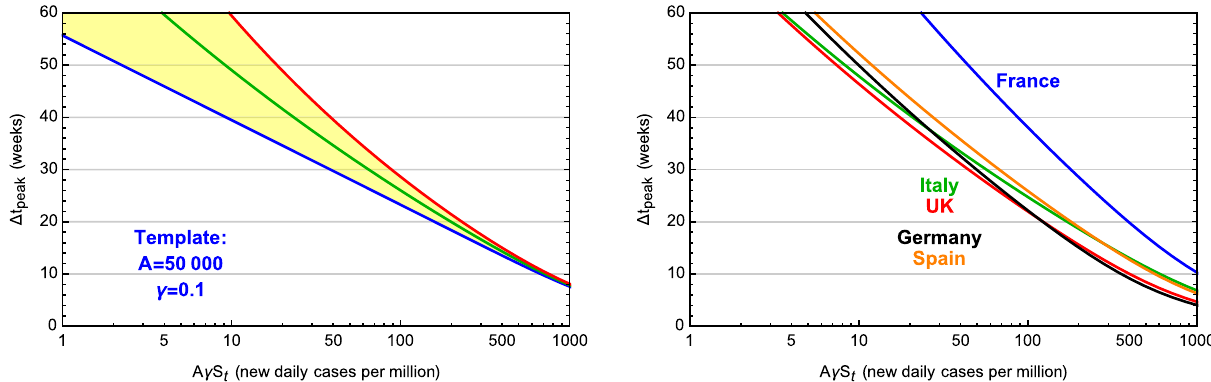
Figure 2. Strolling control to delay the next wave. Delay of the next peak (in real time weeks) as a function of the strolling severity, expressed in terms of the daily number of new infected cases per million inhabitants ( A γ S t ). In the right panel, we show the results for the CeRG model applied to France, Italy, the UK, Germany and Spain. In the left panel we show the result for a template country with A = 50, 000 and γ = 0.1 . The band is given by varying p 0 between 0.5 and